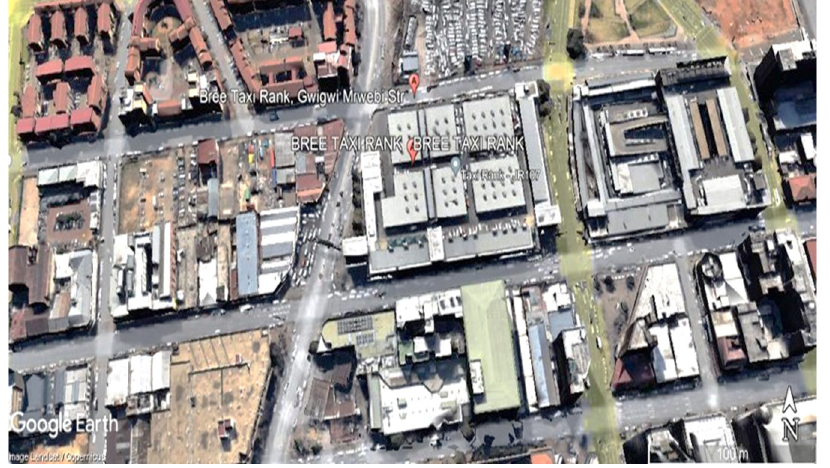
Figure 2. A map showing sampling location (HEG-1 market) in the inner city of Johannesburg [18].